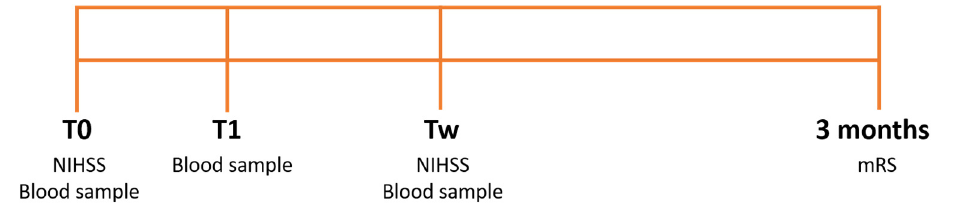
Figure 1. Study protocol. Stroke severity was assessed through the National Institutes of Health Stroke Scale (NIHSS) at admission (T0) and after one week (Tw) and through the Modified Rankin Scale (mRS) after 3 months. Blood samples were collected at T0, after the reperfusion therapy, or 2 h after the first blood sample (T1) and at Tw.